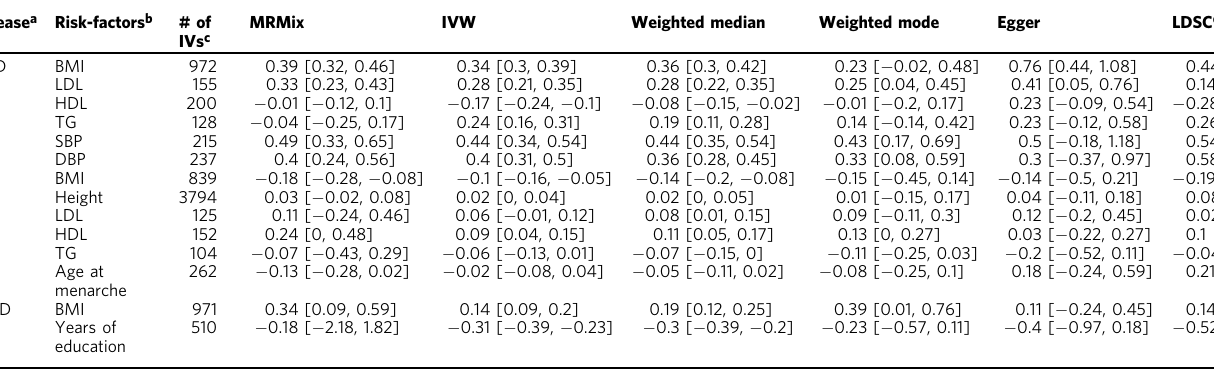
Table 1 Estimates and 95% con fi dence intervals for causal effects (log-OR of disease per SD-unit increase in risk-factor) of various putative risk-factors on three disease outcomes Disease a Risk-factors